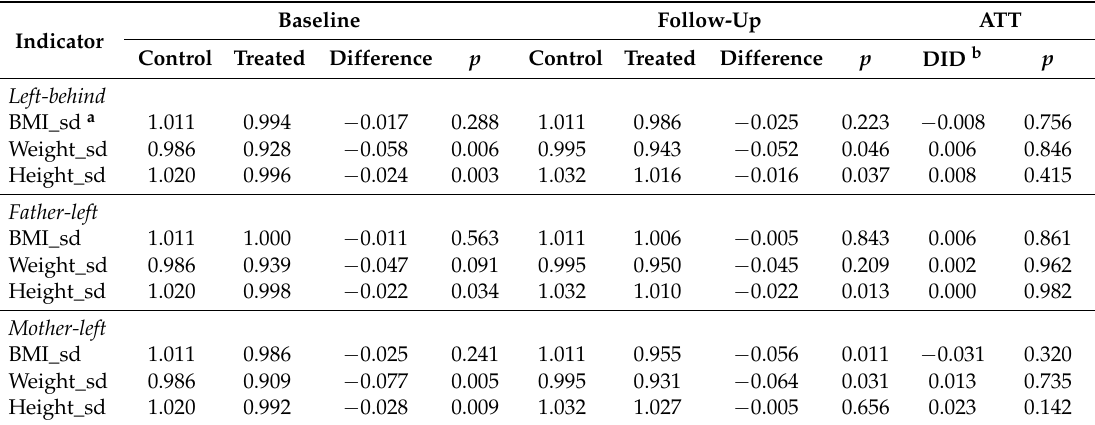
Table 3. Average treatment effect of treated on growth caused by parents’ migration.